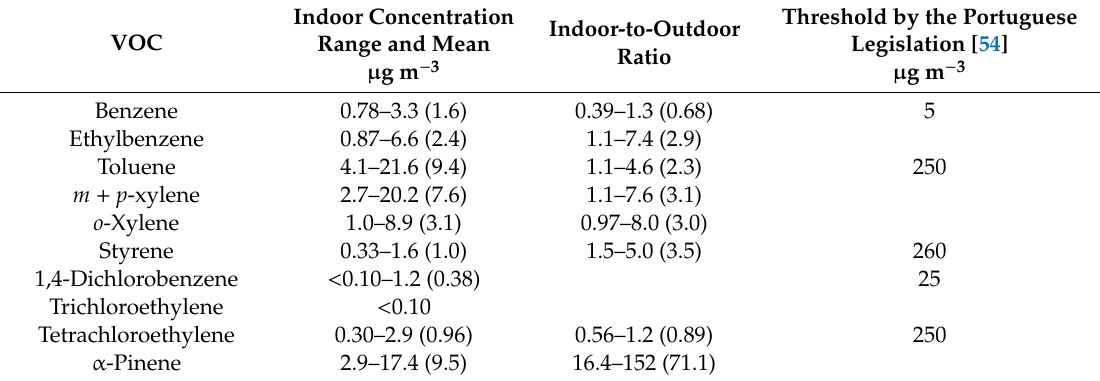
Table 4. Minimum, maximum and mean values for VOC concentrations and I / O ratios, and legal limits.